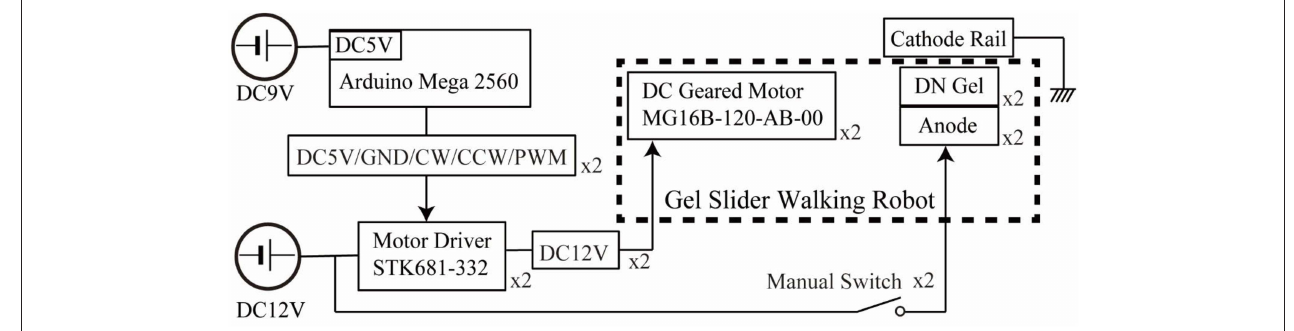
FIGURE 8 | Schematic diagram of the control circuit of the inchworm search